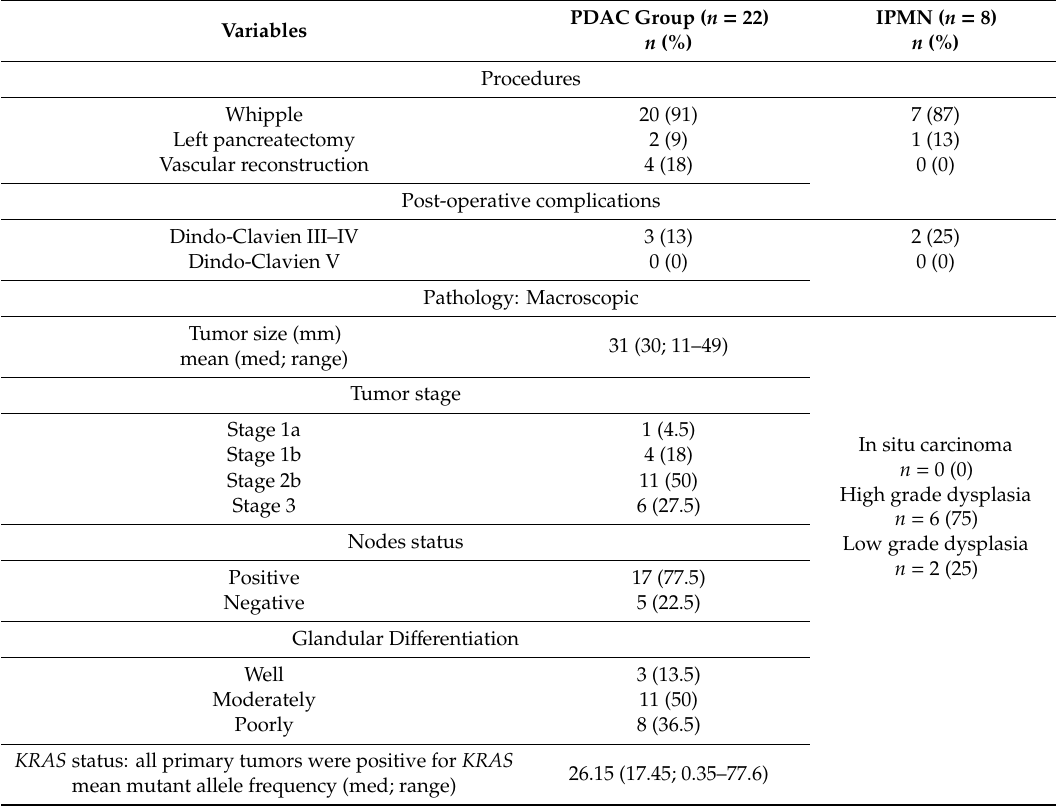
Table 1. Details for pancreatic surgery and pathologic features ( n =